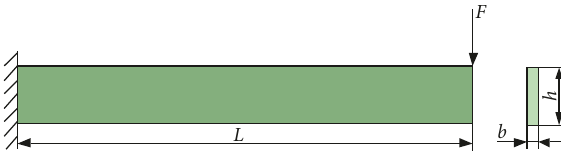
Figure 3: Geometry of the cantilever Table 1: Material constants.